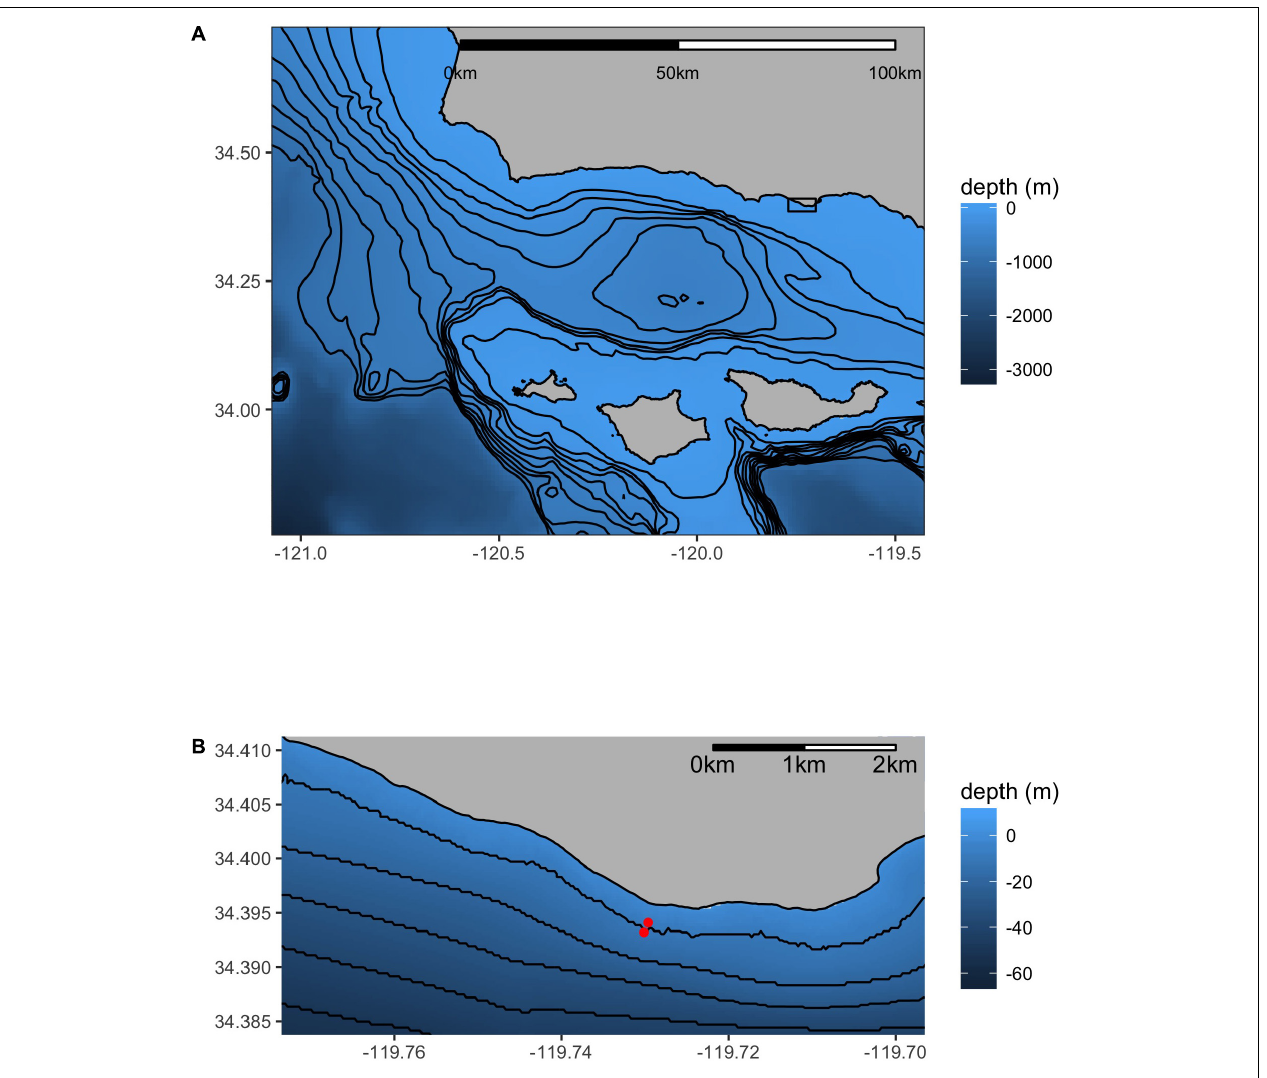
FIGURE 1 | Map of the research site – Mohawk Reef (MKO). The inset (B) details the sites relative to the coastline in close proximity (130 m apart). The “inside” site is northwest (inshore) of the “outside” site. Isobaths are 100 m (A) or 10 m (B)